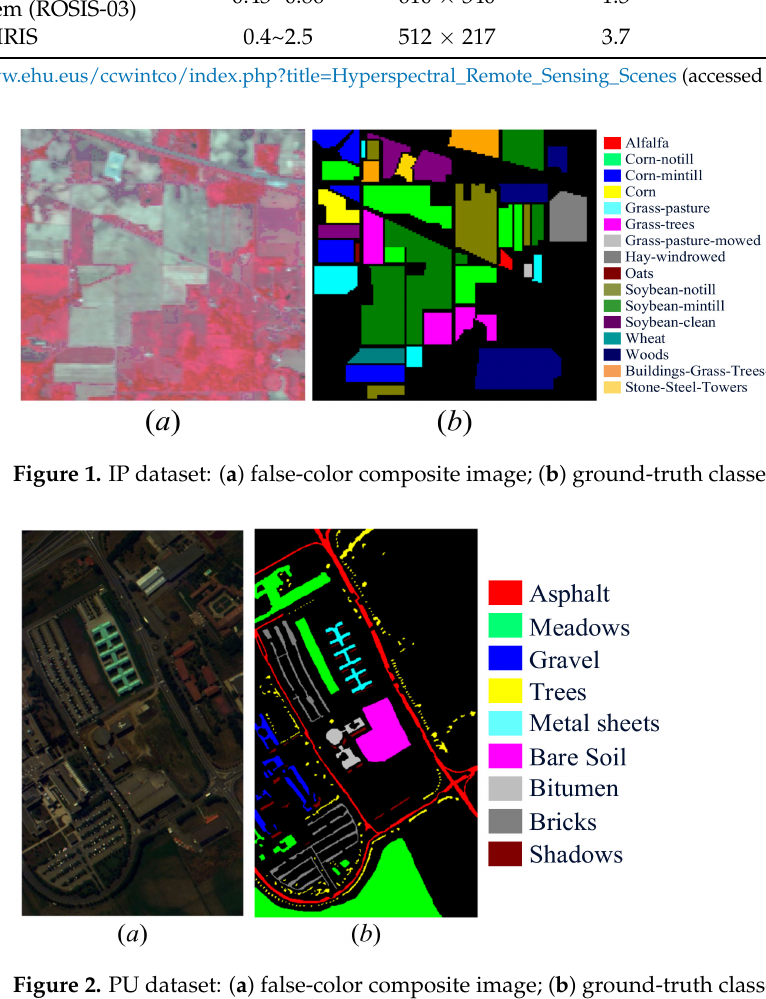
Figure 2. PU dataset: ( a ) false-color composite image; ( b ) ground-truth classes.